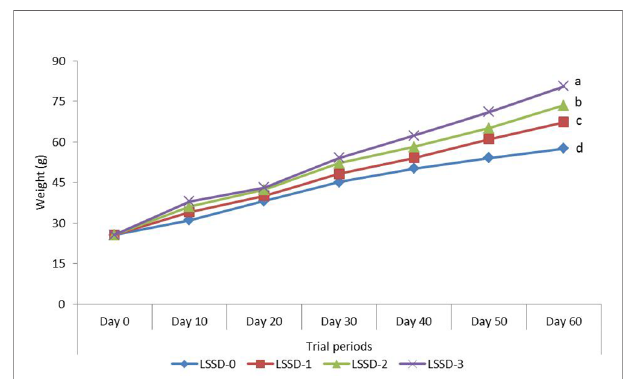
FIGURE 2 | Growth performance of O. niloticus fed 0, 1, 2, and 3% diet of L. siceraria seeds supplemented diets (LSSD) for 60 days. Different superscript letters indicate signi fi cantly different (ANOVA, P < 0.05 ).